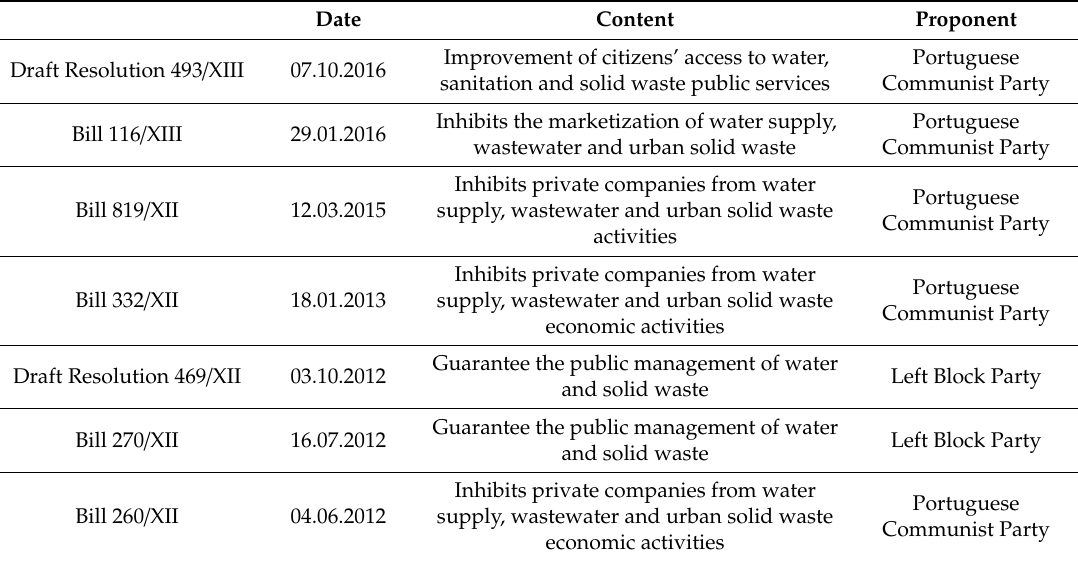
Table 3. Legal initiatives without an explicit reference to the